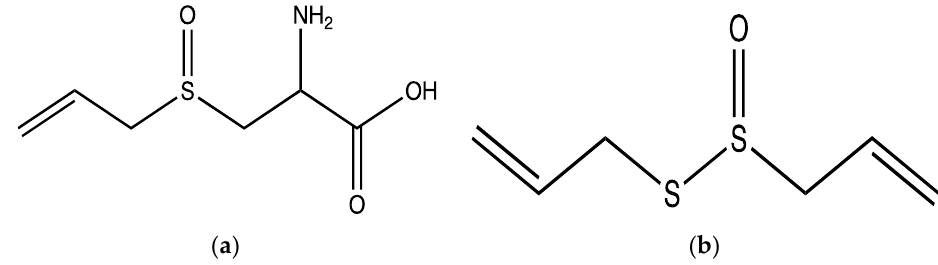
Figure 3. Structure of alliin ( a ) and ( b ) allicin isolated from the methanolic extract of A. sativum